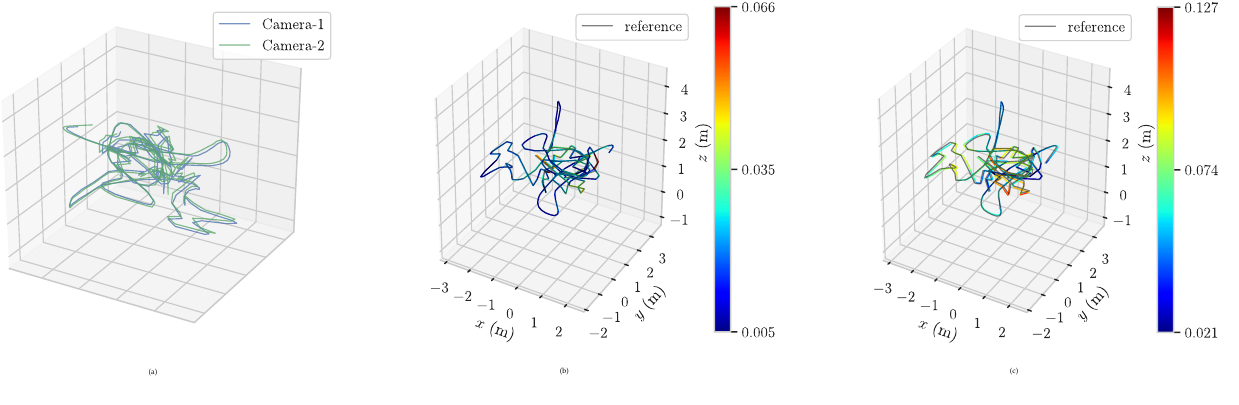
Figure 6. ( a ) The reference and nonreference camera trajectories in EuRoc/ASL V1_03 sequence. ( b , c ) The comparison of the left and the right camera with the ground truth data on EuRoc/ASL V1_03. The color bar represents the error of the estimated trajectory compared to the ground truth data. As the trajectory turns into blue, the error gets